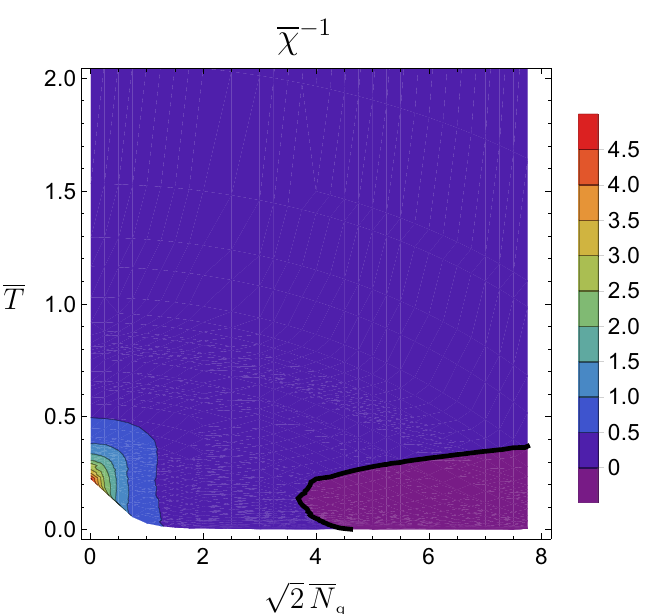
Figure 16 . Contour plot of the inverse charge susceptibility. The thick, black, continuous curve indicates the locus where χ − 1 changes sign.